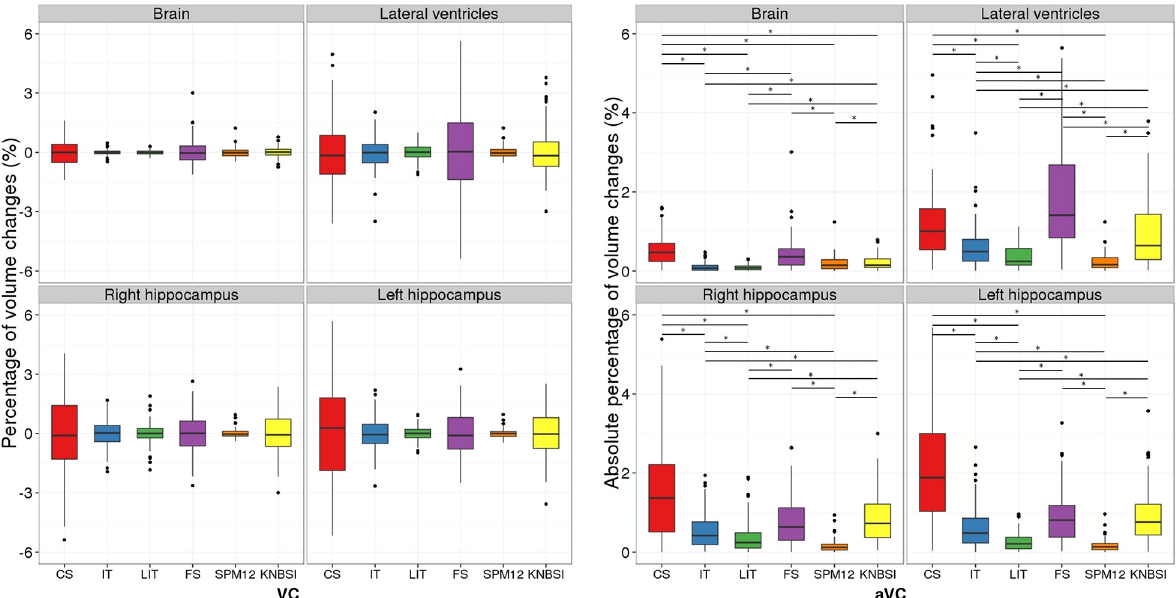
Fig 5. Brain, ventricle and left/right hippocampus percentage of volume change for the scan-rescan dataset for the different methods (CS, IT, LIT, FS, SPM12 and KNBSI). The significant difference (p < 0.01) computed with a match paired Wilcoxon sign-rank are represented by a * where the pairs are represented by the thicker horizontal